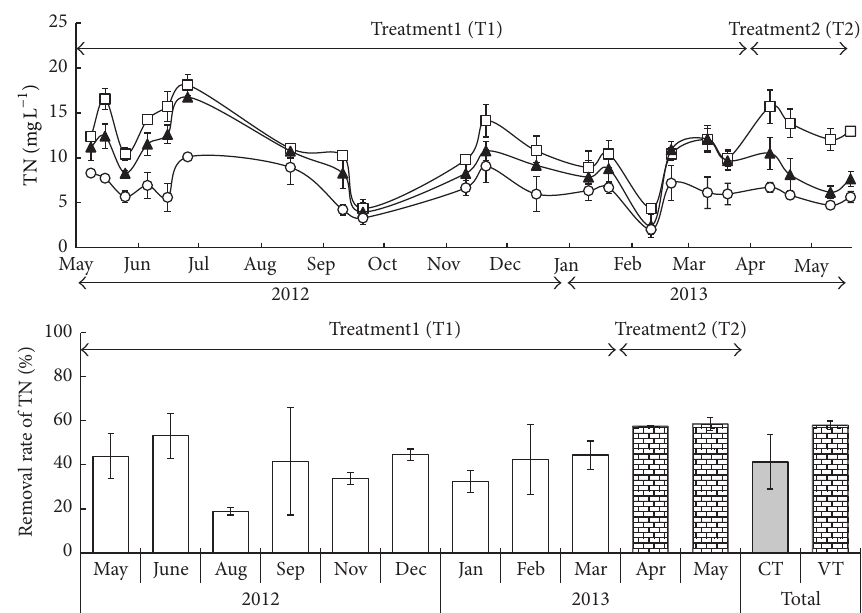
Figure 5: The concentration and removal rate of TN in the water with time in a VF-HF hybrid constructed wetland under different ventilation methods ( ◻ : inflow; 󳵳 : 1st treatment; I : 1st + 2nd treatment; Treatment1 (T1): VF-HF CWs with natural ventilation; Treatment2 (T2): VF-HF CWs with ventilation using an electric air fan